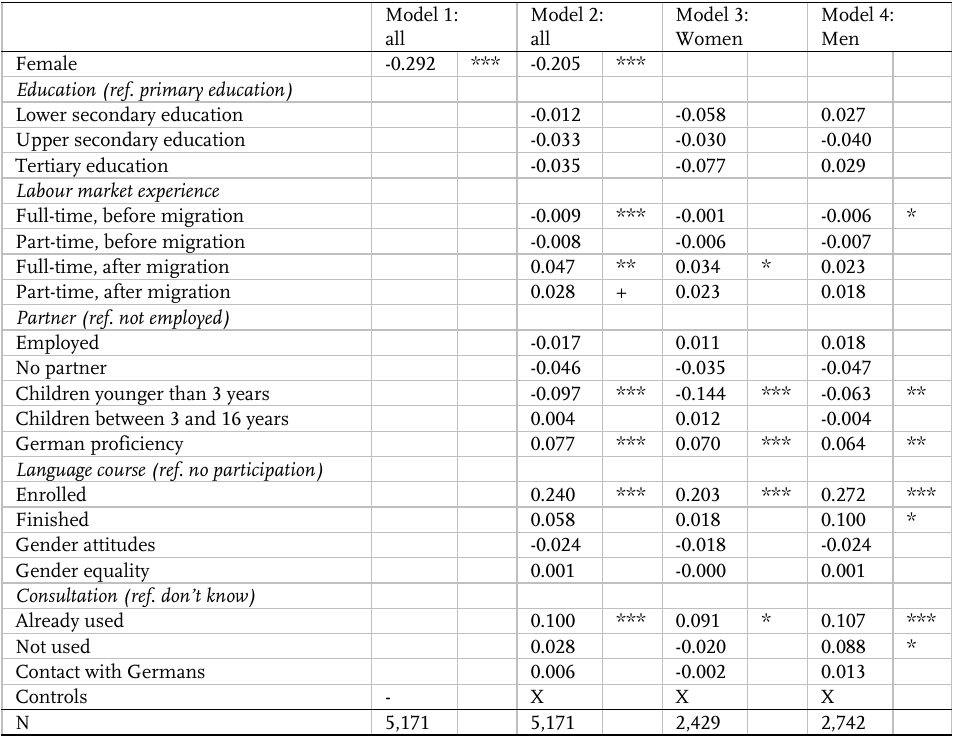
Table 2 : Results from logistic regression (1: Labour market participation; 0: No labour market participation), pooled models and models by gender, average marginal effects (AME)